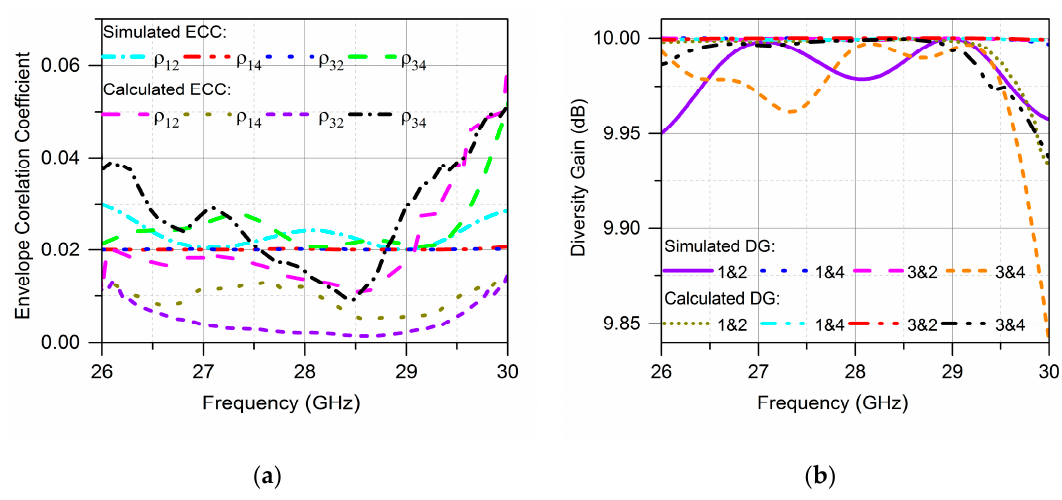
Figure 9. ( a ) ECC of the proposed MIMO antenna array ( b ) Diversity Gain of the MIMO antenna array.